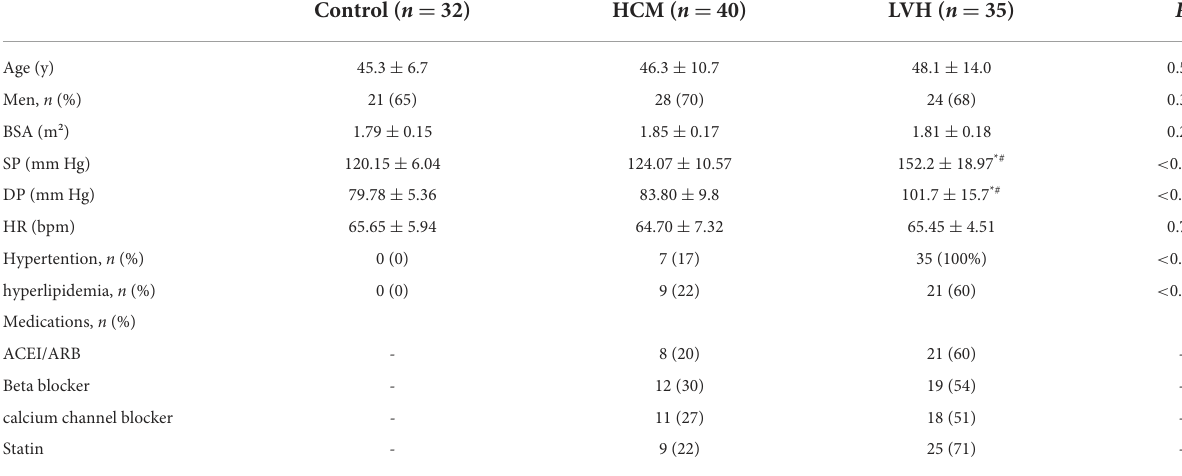
TABLE 1 General characteristics for study groups.